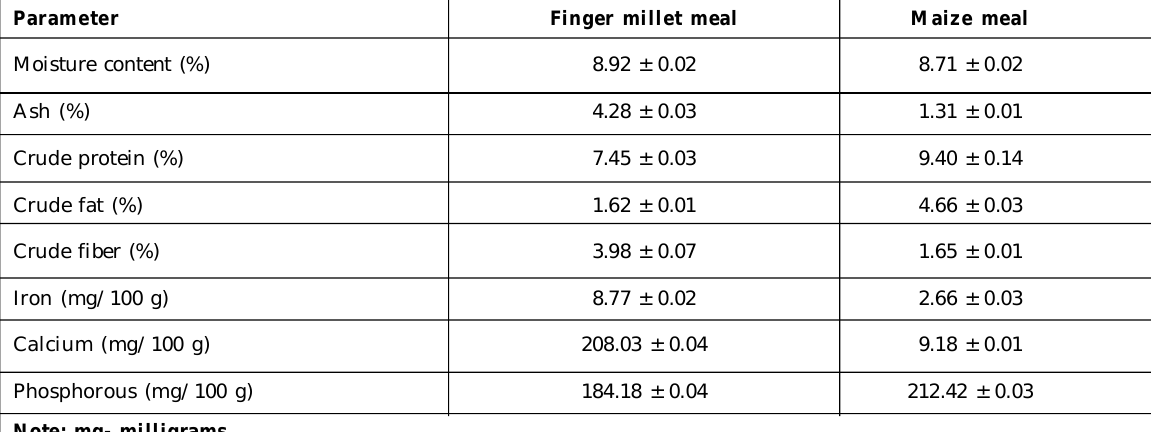
Table 1: Nutritional composition of finger millet meal and maize Parameter Finger millet meal Maize meal Moisture content (%)